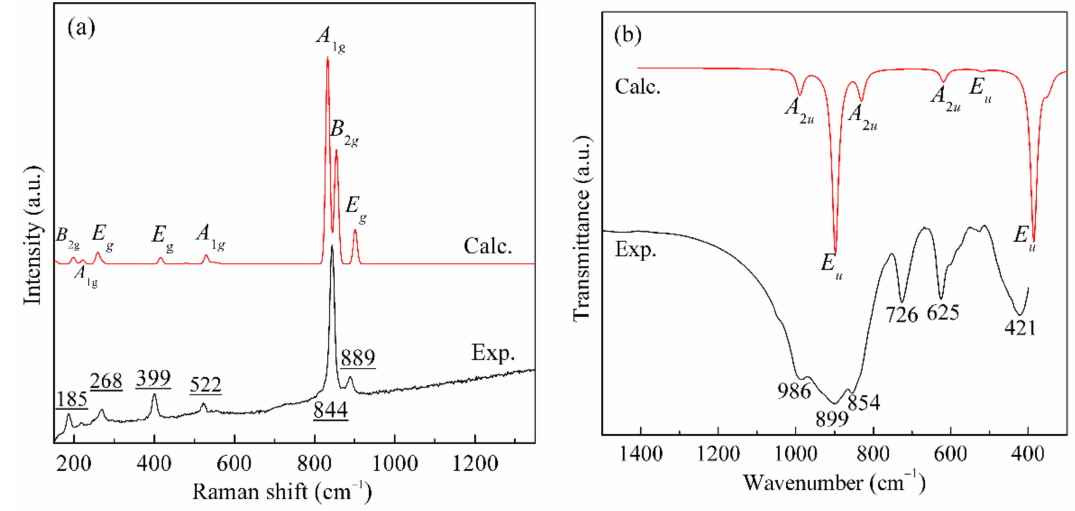
Figure 4. Raman spectra ( a ) and IR spectra ( b ) of natisite from calculation and